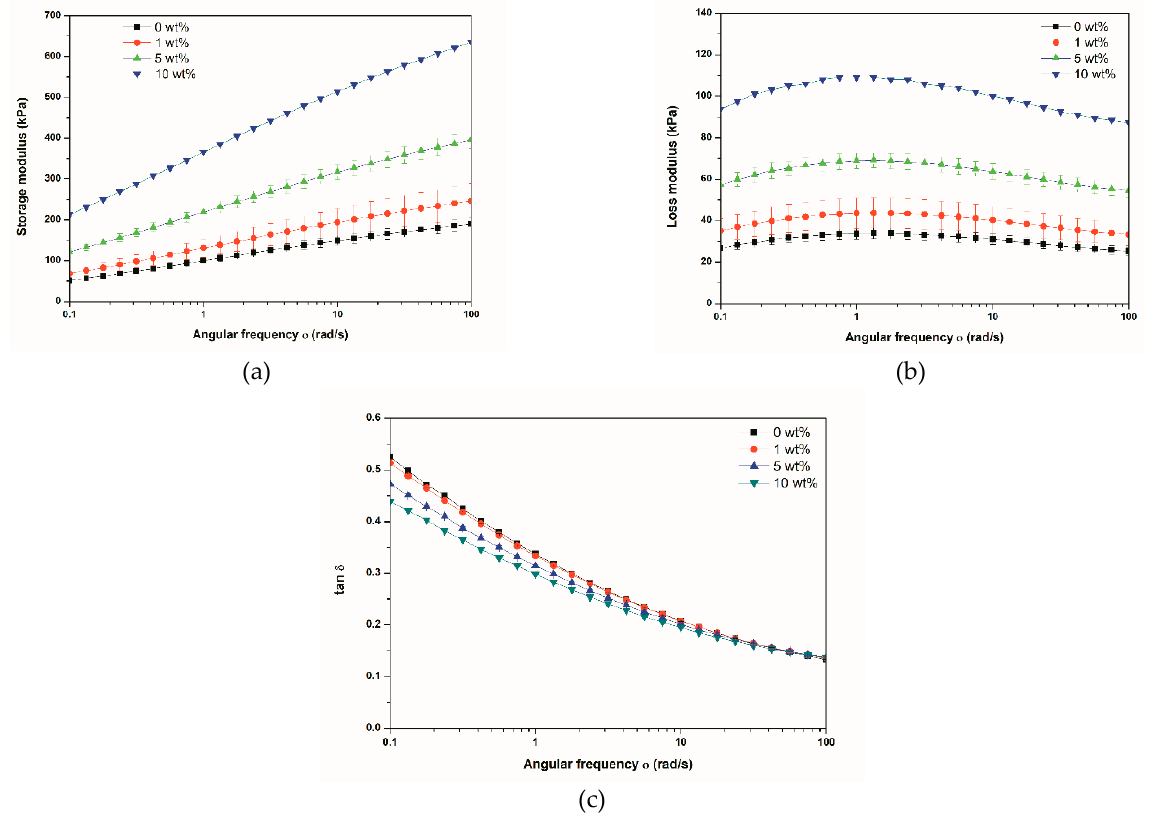
Figure 5. Variation of storage modulus (G’) ( a ), loss modulus (G’’) ( b ), and tan δ ( c ) of SBR/BNNTs as a function of angular frequency.